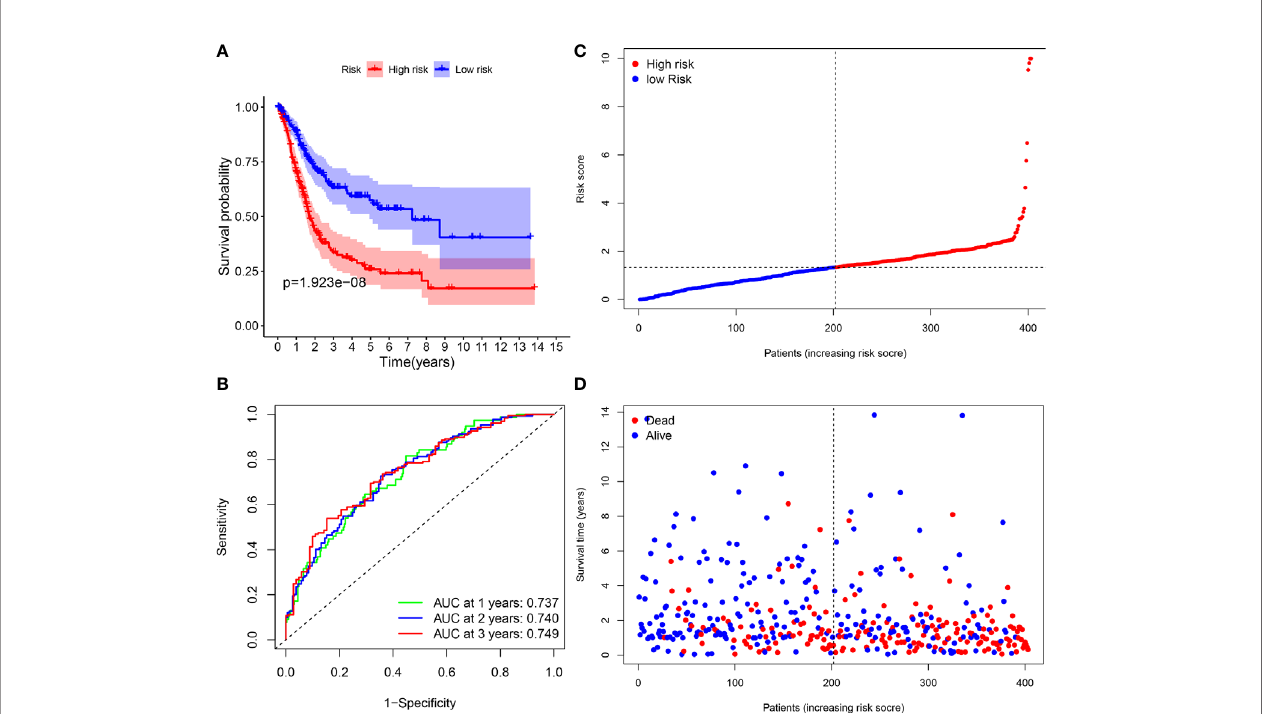
FIGURE 8 | Survival analyses of the signature. (A) The Kaplan-Meier survival curve analysis showing the signi fi cant difference between the high-risk and the low-risk groups ( p < 0.05). (B) Time-dependent ROC curve analysis showing the signi fi cant prognostic value (all AUC value > 0.70). (C) Risk score distribution of the patients. (D) Survival status scatter plots showing poorer prognosis of the high-risk group compared with the low-risk group.